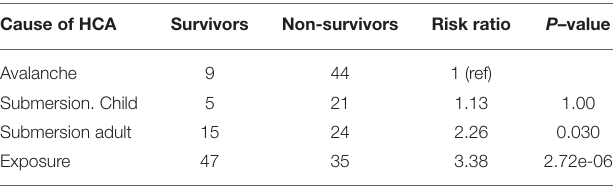
score was 33.9 ± 33% with medians of 58.5% (48%) and TABLE 3 | Risk ratios of victims of hypothermic cardiac arrest with survival as outcome and avalanche as reference category. Cause of HCA Survivors Non-survivors Risk ratio P –value 9 44 1 (ref)